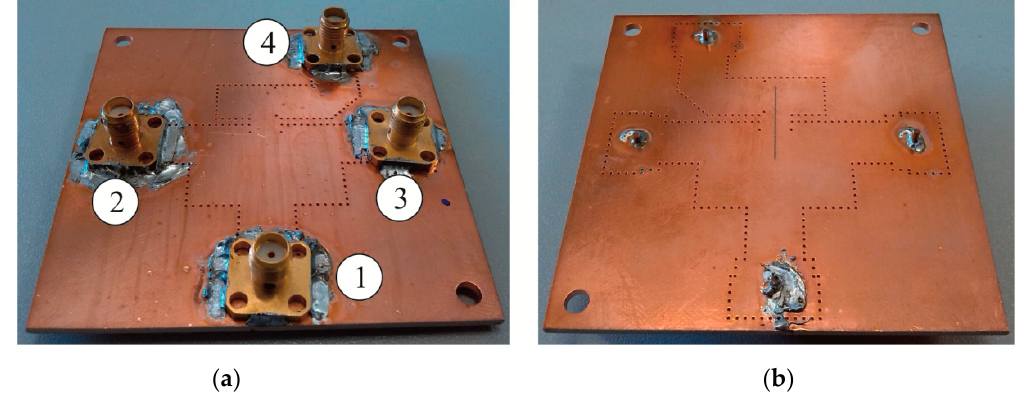
Figure 14. Single-layer Magic Tee prototype. ( a ) top view; ( b ) bottom view.